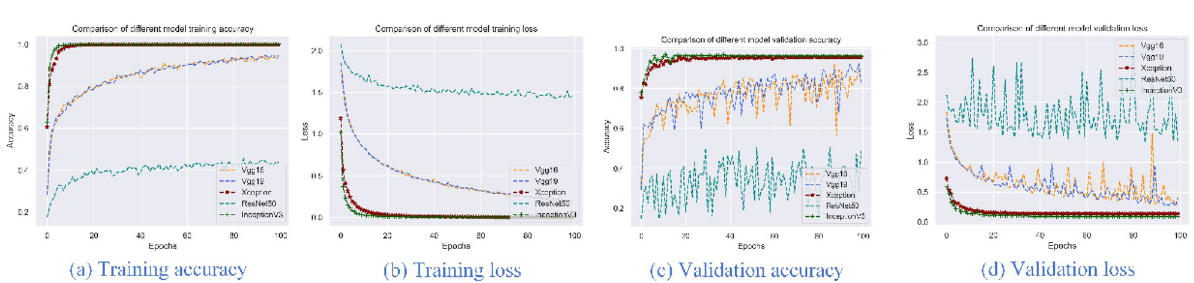
Figure 4. Accuracy and loss for five different models using image_gray